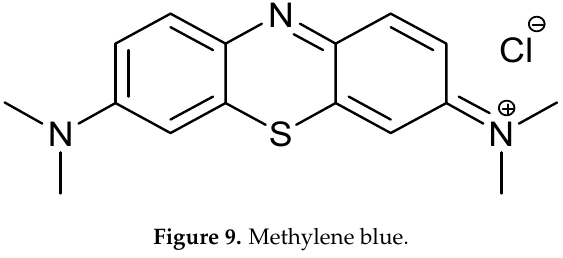
Figure 9. Methylene blue.